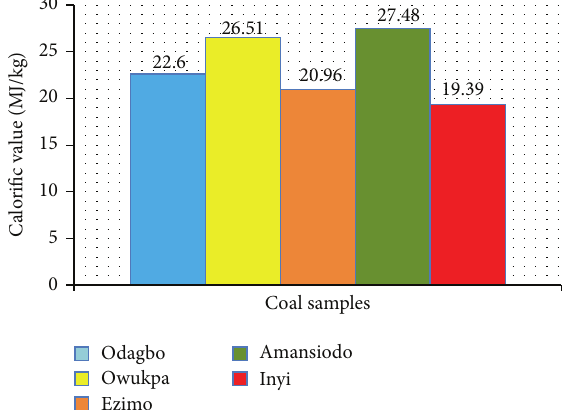
Figure 2: Calorific value of the five coal samples.